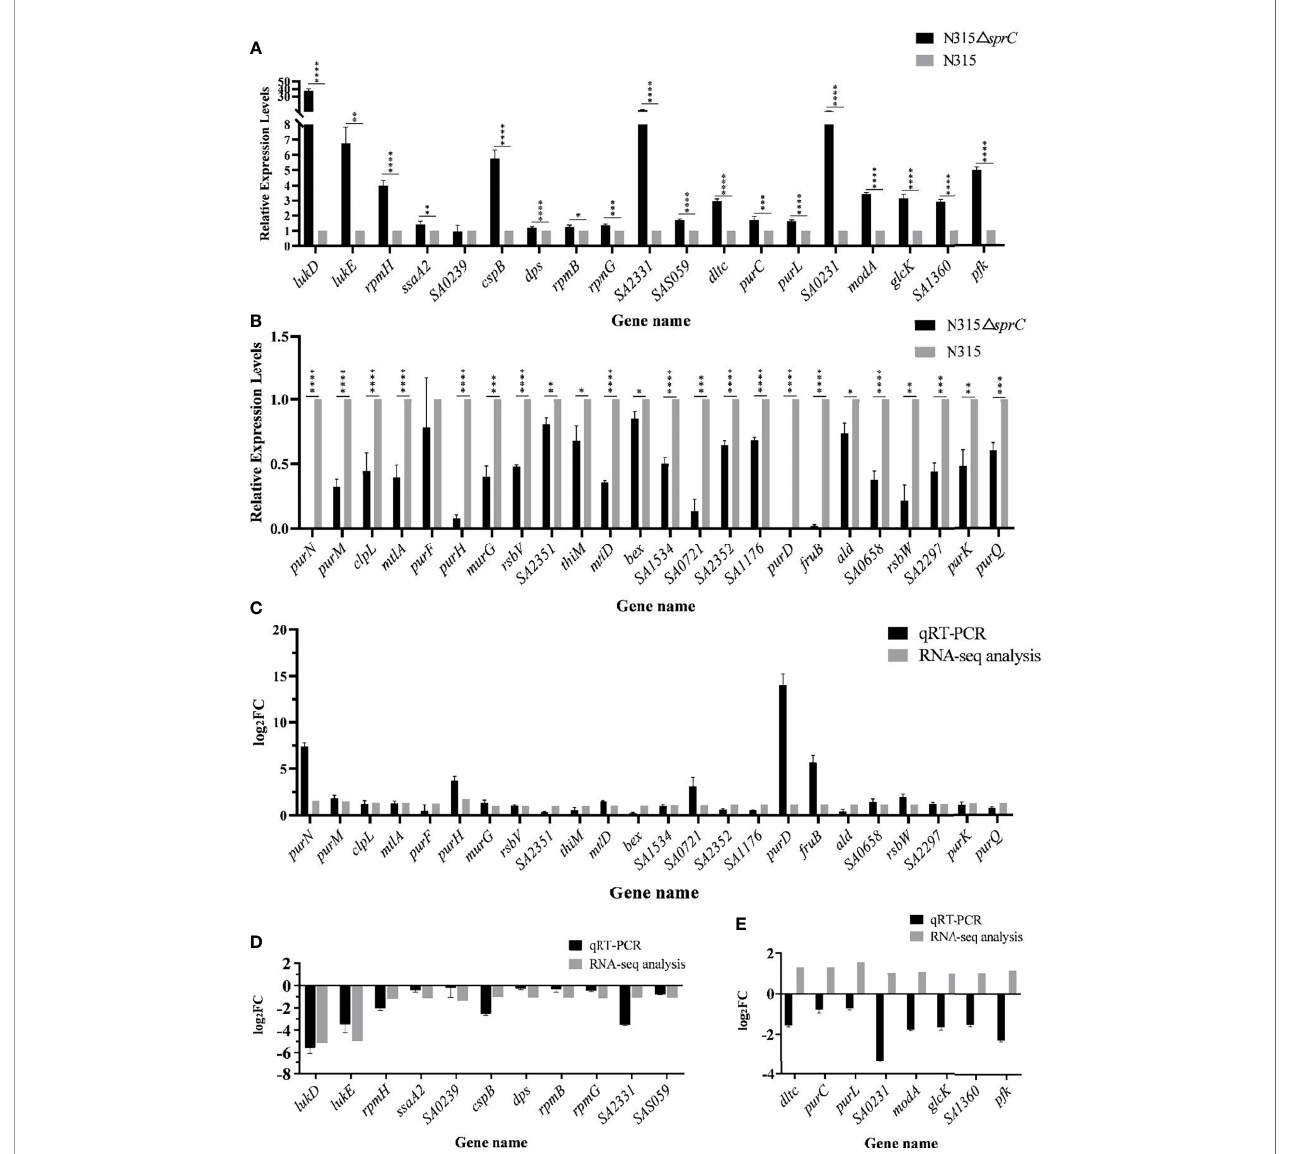
FIGURE 4 | qRT-PCR analysis for validation of expression levels of 43 DEGs with de fi ned function between N315 and N315 D SprC strains. (A) 19 DEGs were up- regulated after the sprC knockout analyzed by qRT-PCR. (B) 24 DEGs were down-regulated after the sprC deletion. Black bar, strain N315 D sprC ; gray bar, strain N315 * P < 0.05, ** P < 0.01, *** P < 0.001, **** P < 0.0001. The consistence of the results between RNA-seq and qRT-PCR analyzed with log 2 (Fold change) (log2FC) (y-axis) was shown in (C – E) . (C, D) 24 up-regulated and 11 down-regulated genes by SprC were validated consistent between both methods. (E) The